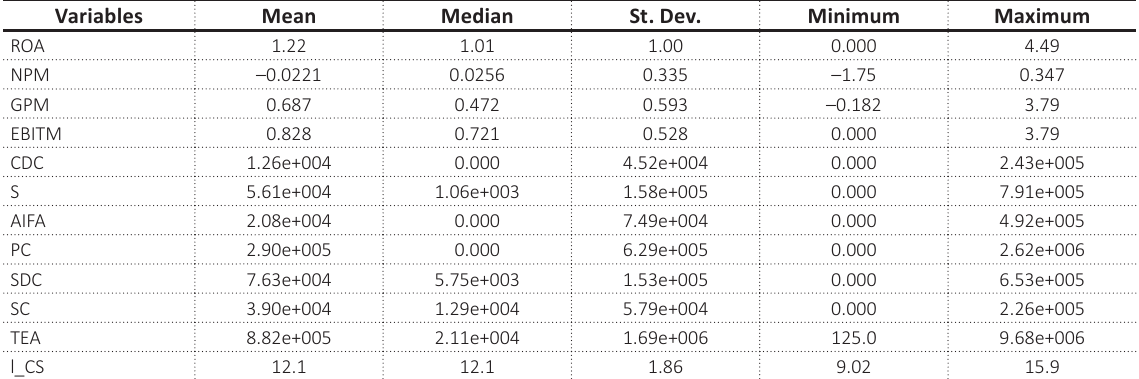
Source: Calculated via Gretl software